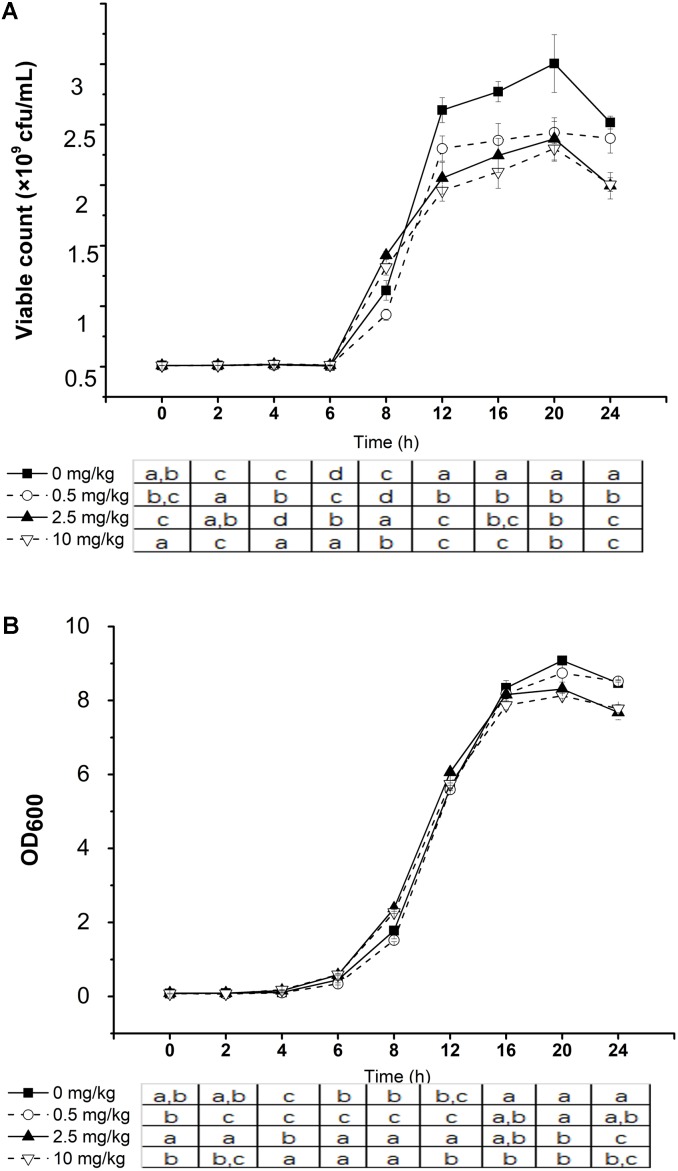
Effect of phorate concentration on the growth of Lactobacillus plantarum P9. Viable count (A) and optical density at 600 nm (B) in the same fermentation. Significant differences between pesticide concentration used are shown by different letters (∗P < 0.05). Error bars represent standard deviation.